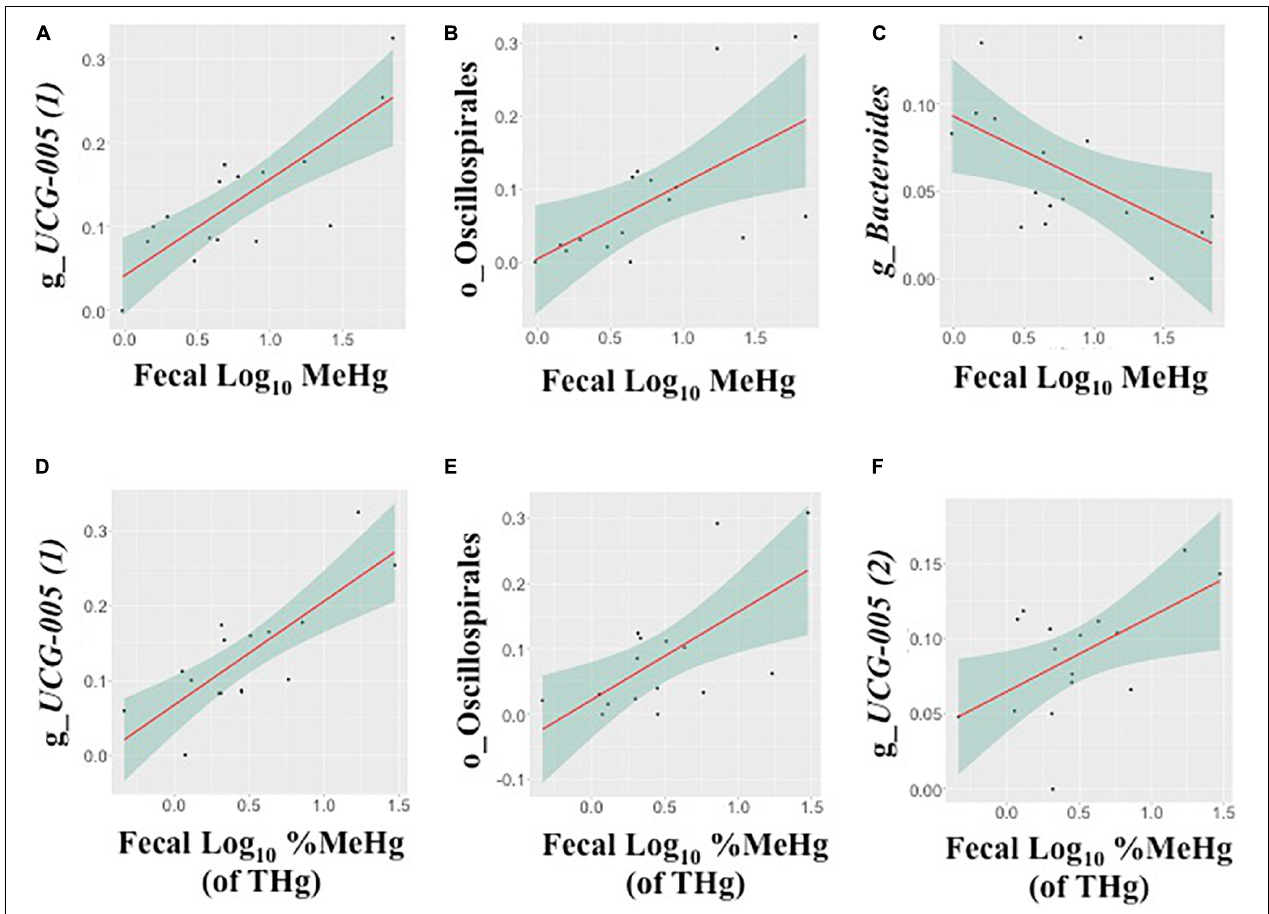
FIGURE 3 | Associations between the relative abundance of gut microbiota amplicon sequence variants (ASVs, arcsine-square root transformed) and fecal methylmercury (MeHg) (A–C) or %MeHg [of total mercury (THg)] (D–F) (both log 10 -transformed), including (A) genus UCG-005 (1) (family: Oscillospiraceae ), (B) order Oscillospirales, (C) genus Bacteroides (family: Bacteroidaceae ), (D) genus UCG-005 (1) (family: Oscillospiraceae ), (E) order Oscillospirales, and (F) genus UCG-005 (2) (family: Oscillospiraceae ) ( n = 16 walruses). Each plot includes the linear regression line ± standard error of the regression line (see Table 4